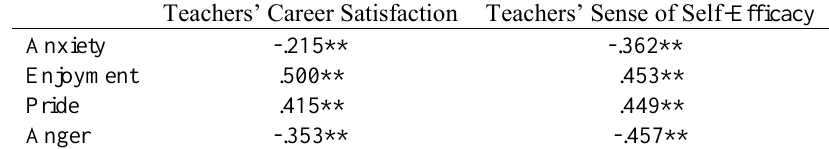
Convergent Validity (Korean